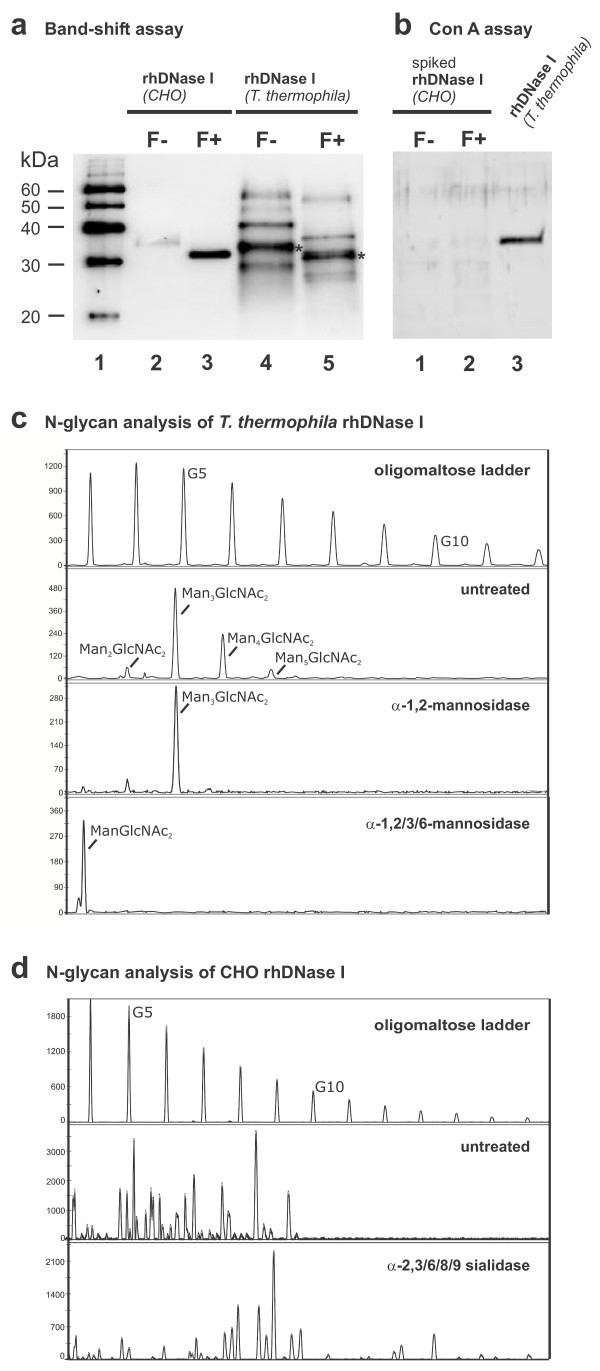
N-glycan structure on recombinant secreted human DNase I. a: Band-shift assay: rhDNase I from CHO cells and secreted rhDNase I from T. thermophila were de-glycosylated. The treatment with PNGase F (F+) results in a significant band-shift, when compared to the controls (F-), illustrating that the secreted rhDNase I of T. thermophila becomes glycosylated. As T. thermophila rhDNase I had been concentrated by immunoprecipitation, additional bands of antibody-chains appear in Western blotting. The DNase signals are highlighted by asterisks. b: Concanavalin A pulldown assay: Supernatants of transformed T. thermophila strain and a wildtype strain (B1868.7) were analysed. The supernatant of the wildtype was spiked with equal amounts (2 μg) of glycosylated (F-) or de-glycosylated (F+) rhDNase I from CHO cells, respectively. Only mannose-terminated glycosylated rhDNase is recovered by Con A (lane 3), glycosylated (F-) and de-glycosylated rhDNase I (F+) from CHO cells did not bind to ConA beads (lanes 1 and 2). c: DSA-FACE N-glycan analysis of T. thermophila rhDNase I: This data illustrates the highly consistent N-glycan structure on rhDNaseI produced in T. thermophila. All N-glycans are mannose terminated, as shown by digestion with jack bean mannosidase in the lower panel. The most prominent structure is the Man3GlcNAc2 core pattern with additional alpha 1,2 bound mannoses (two middle panels). d: DSA-FACE N-glycan analysis of CHO rhDNase I: On the CHO derived rhDNase I more than 20 distinct peaks, each corresponding to a different N-glycan, are observed in the untreated sample. This typical complex profile of mammalian cells is in sharp contrast to the consistent T. thermophila glycosylation. Even removal of terminal N-acetylneuraminic acid by treatment with sialidase still leads to a large number of various glycans (lower panel).